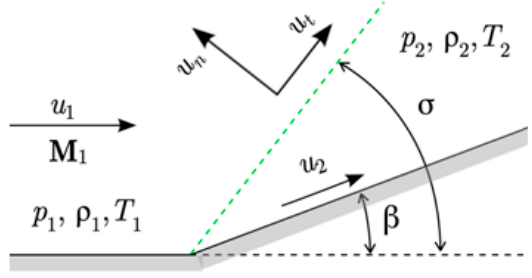
Figure 1. Oblique shock wave. Oblique shocks are reflected from the walls, intersect with other shock waves and refract at tangential discontinuities. If there are many shock waves in the flow, they are usually numbered and the shock direction indicated with arrows—for example, σ Left-handed shocks are indicated by an arrow pointing to the left, and right-handed shocks are indicated by an arrow pointing to the right. The quantities behind the corresponding shock are indicated by a number. For example, the quantities behind the shock are denoted by M 1 and p 1 , and the flow quantities behind the shock are denoted by M 2 and p 2 .